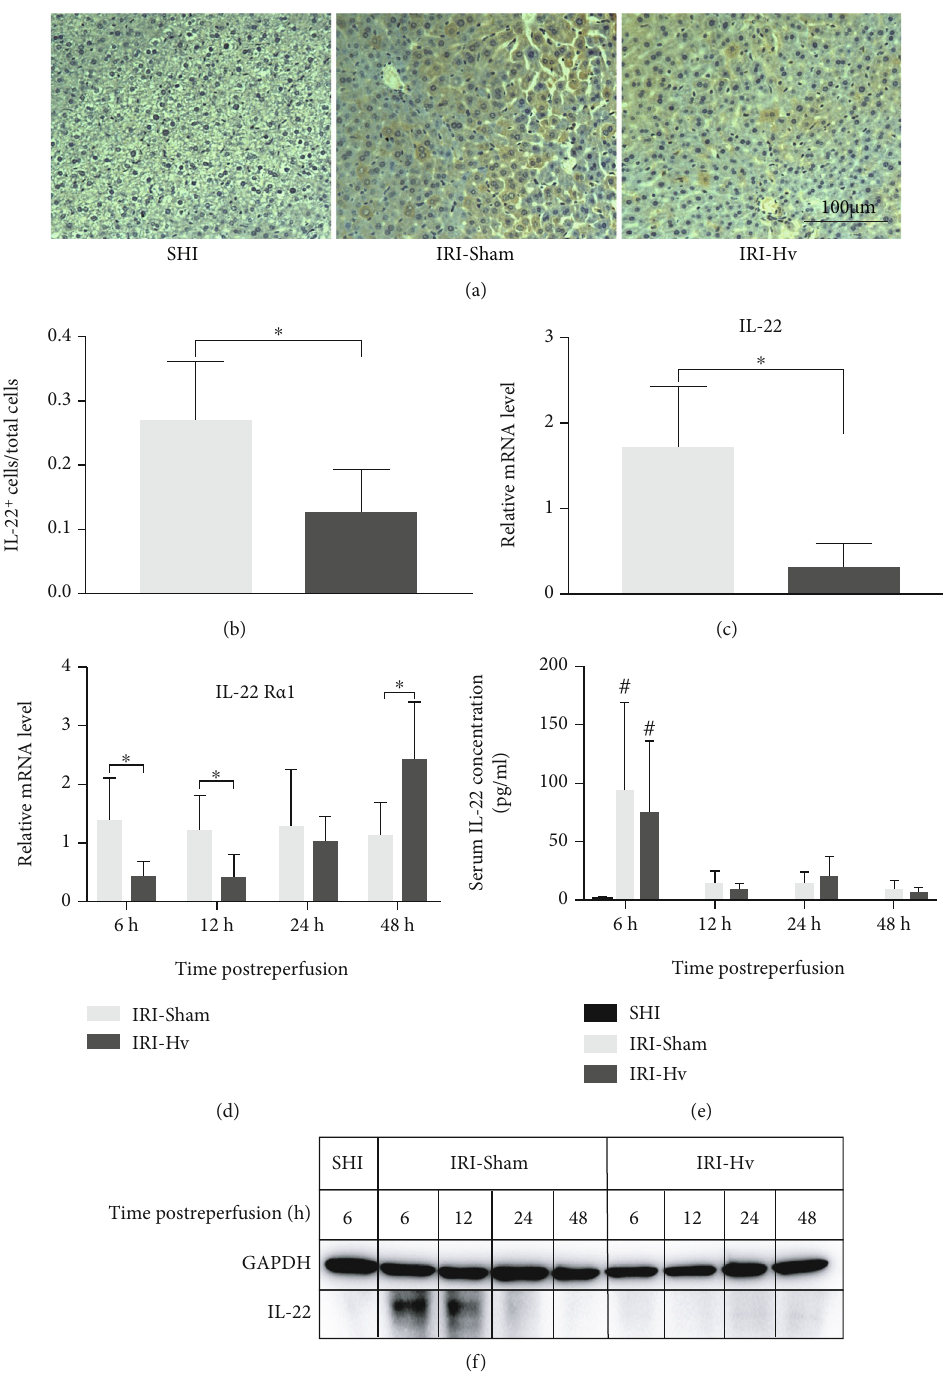
Figure 3: Hepatic vagotomy reduces hepatic IL-22 production induced by ischemia-reperfusion injury. (a) Typical immunohistochemical staining pictures of liver tissues in the three groups of mice at 12h postreperfusion ( × 200 magni fi cation). (b) The positive area of IL-22 staining is shown as brown, and the IL-22 + hepatocyte/total hepatocyte ratio is calculated. (c, d) Expressions of IL-22 (6 h) and IL-22R α 1 mRNA in di ff erent liver tissues. (e, f) Serum IL-22 concentration and the expression of IL-22 protein in the livers of two groups at di ff erent time points after reperfusion ( n = 4 ‐ 6 ; ∗ p < 0 : 05 . Compared with the SHI group: # p < 0 : 05